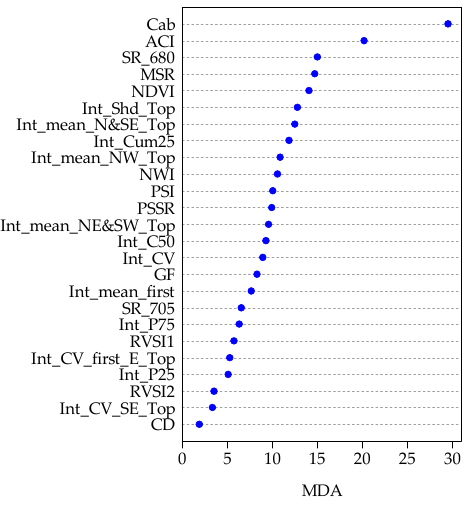
Figure 9. The mean decrease accuracy (MDA) of each variable for SDR estimation, with a combination of hyperspectral variables and lidar metrics.